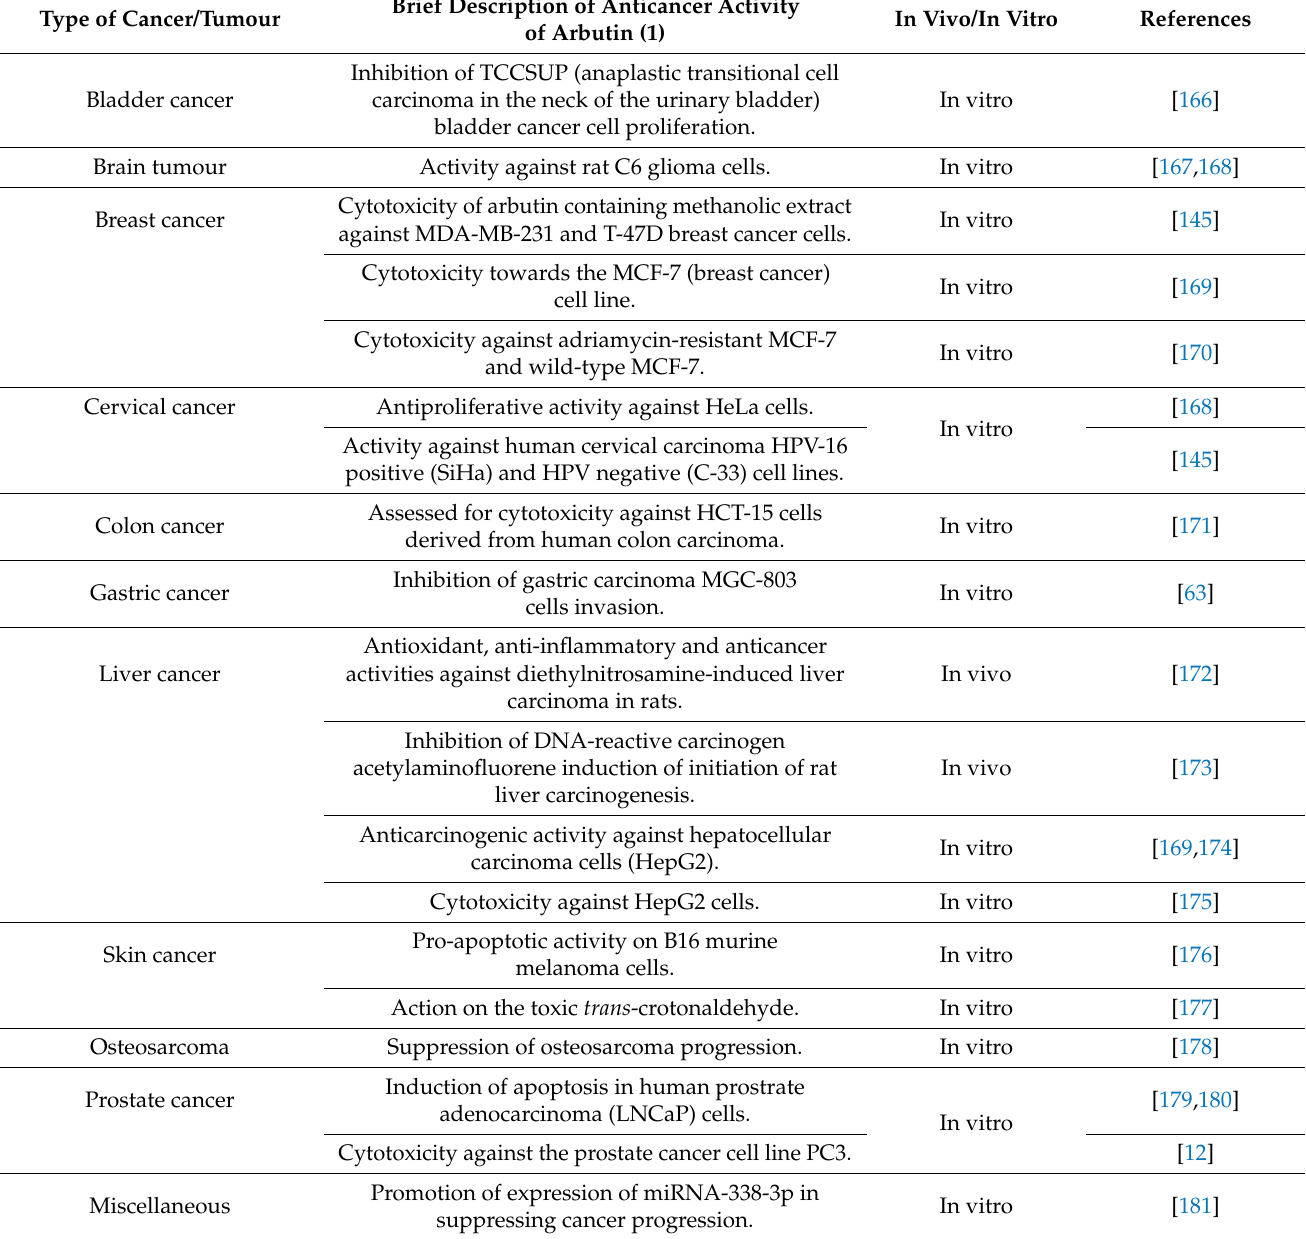
Table 2. Cytotoxicity of arbutin ( 1 ) against various cancer and tumor cell